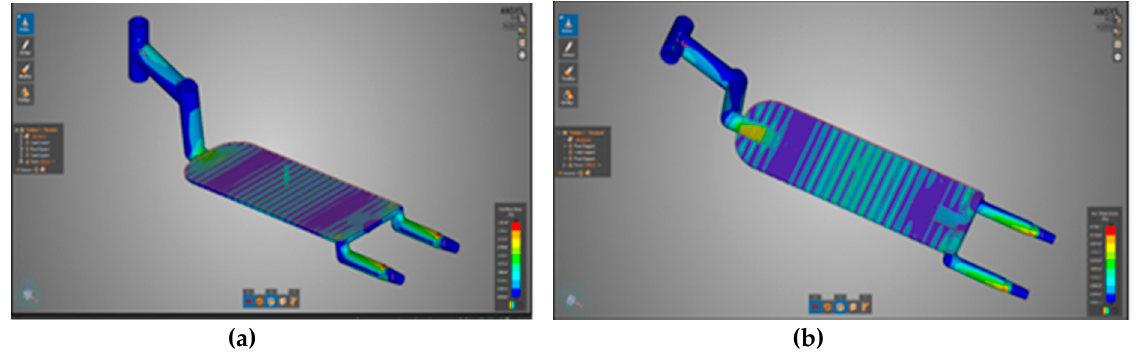
Figure 5. FEA Analysis Results. ( a ) upper part, ( b ) lower part.